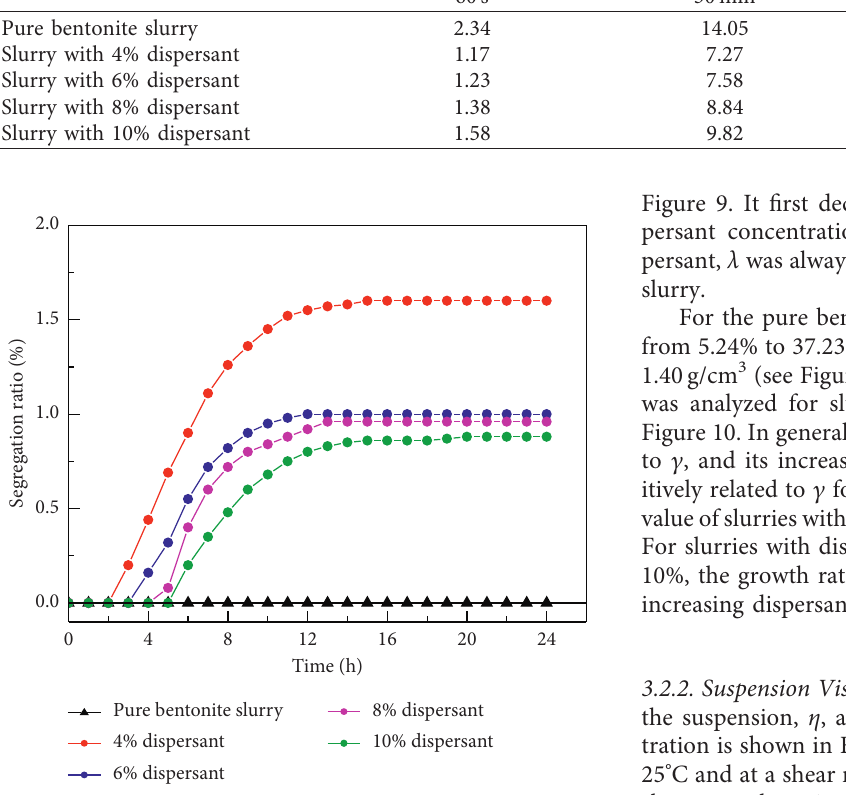
Figure 6: Segregation